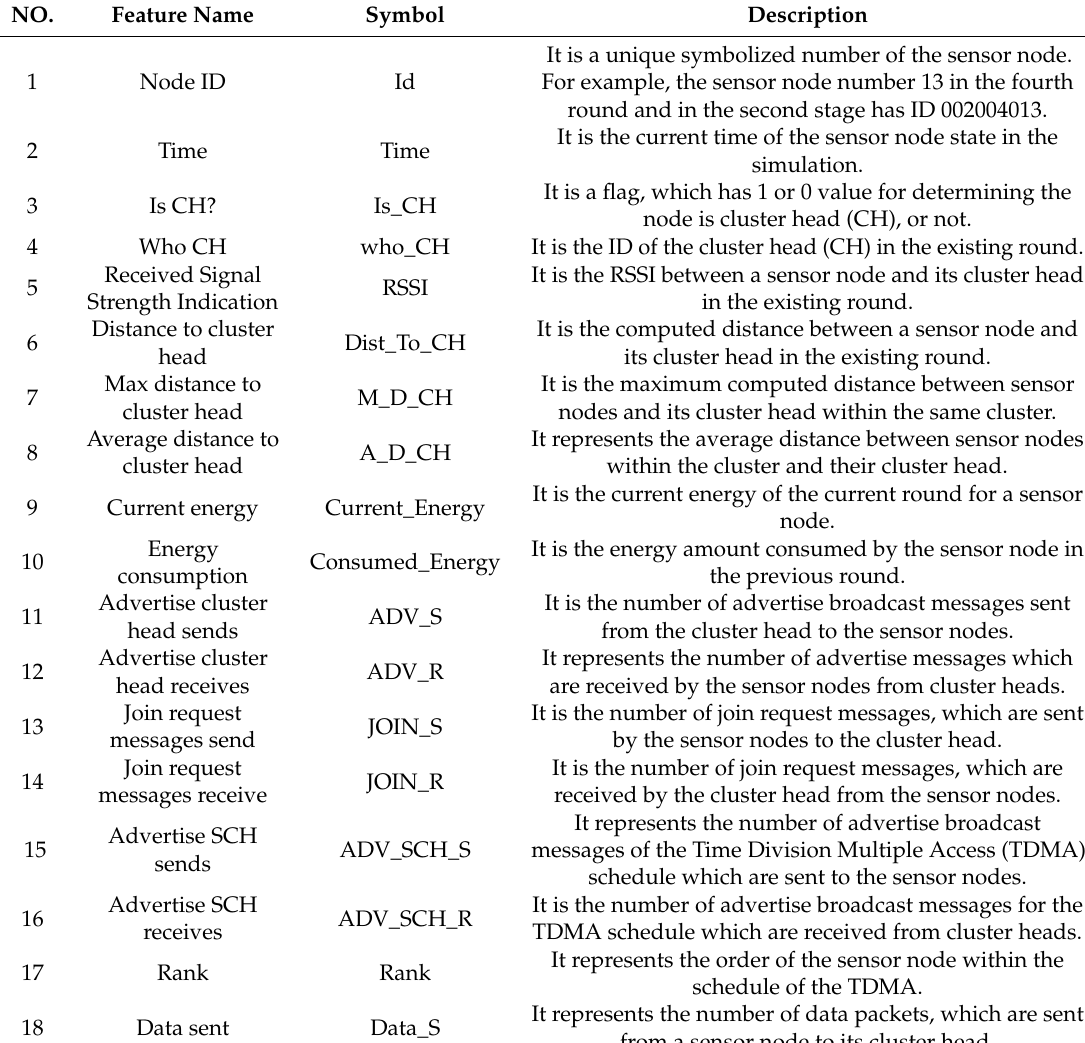
Table 1. Extracted features of the wireless sensor network-detection system (WSN-DS)